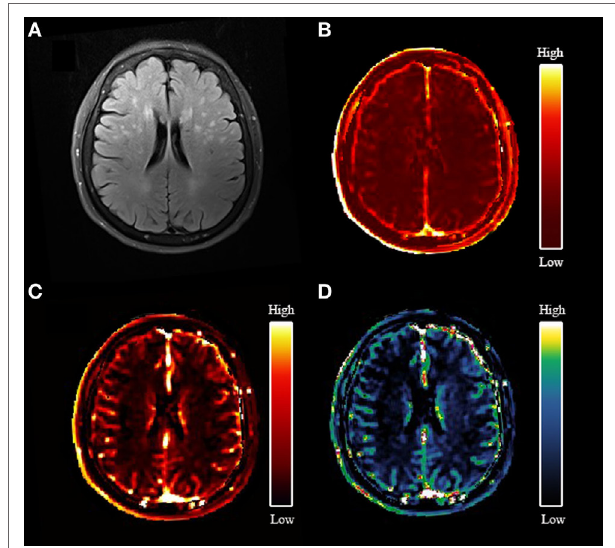
FigUre 2 | An example map. (a) Axial fluid-attenuated inversion recovery image of a 77-year-old woman; (B) blood–brain barrier leakage rate ( K trans ) map; (c) area under the leakage curve map; (D) fractional blood plasma volume ( V p ) map.